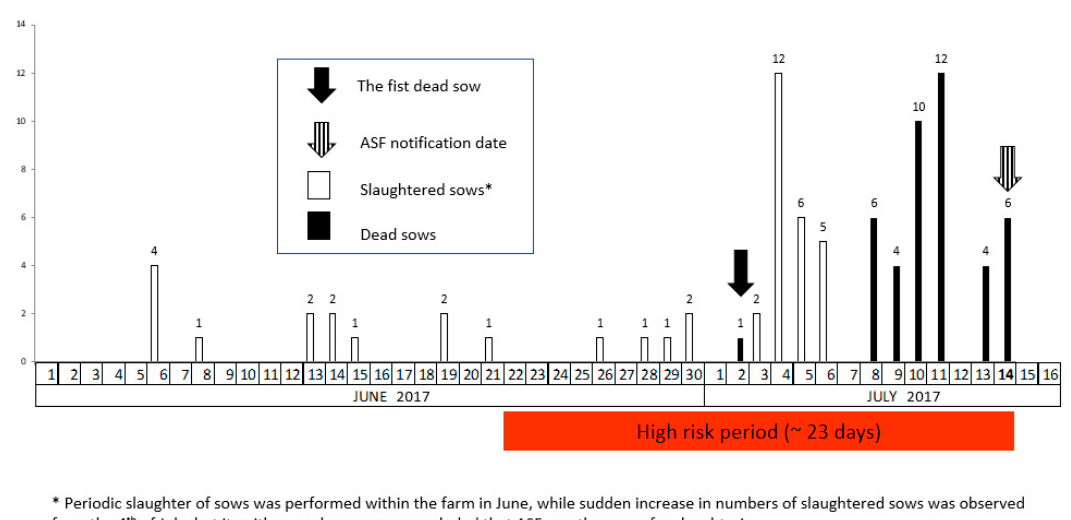
Figure 2. Timeline of the disease event in Farm A, stable 2 and the estimated high risk period.